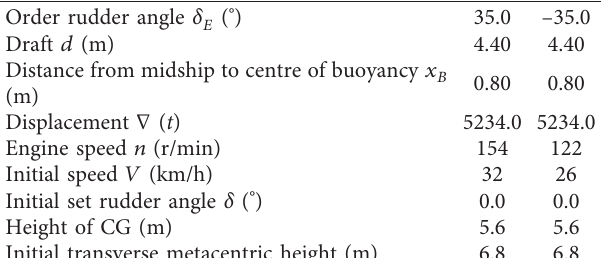
Table 2: Initial state of the target ship in a static water turning circle.